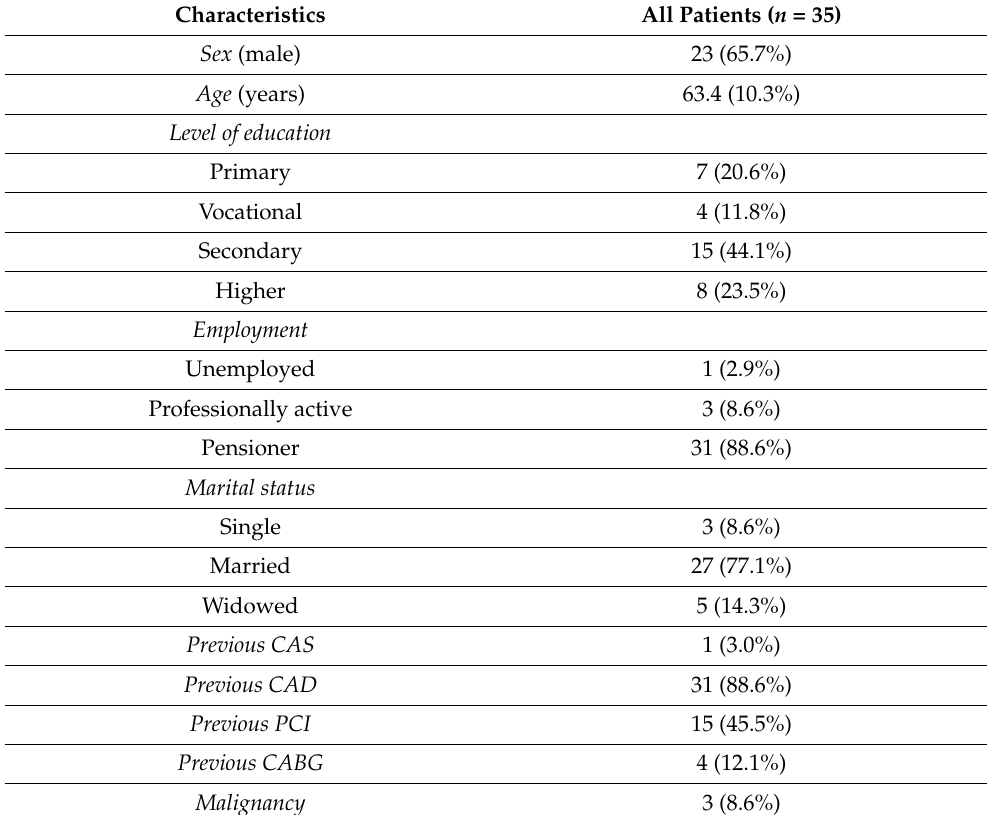
Table 1. Socio-demographic and clinical characteristics.